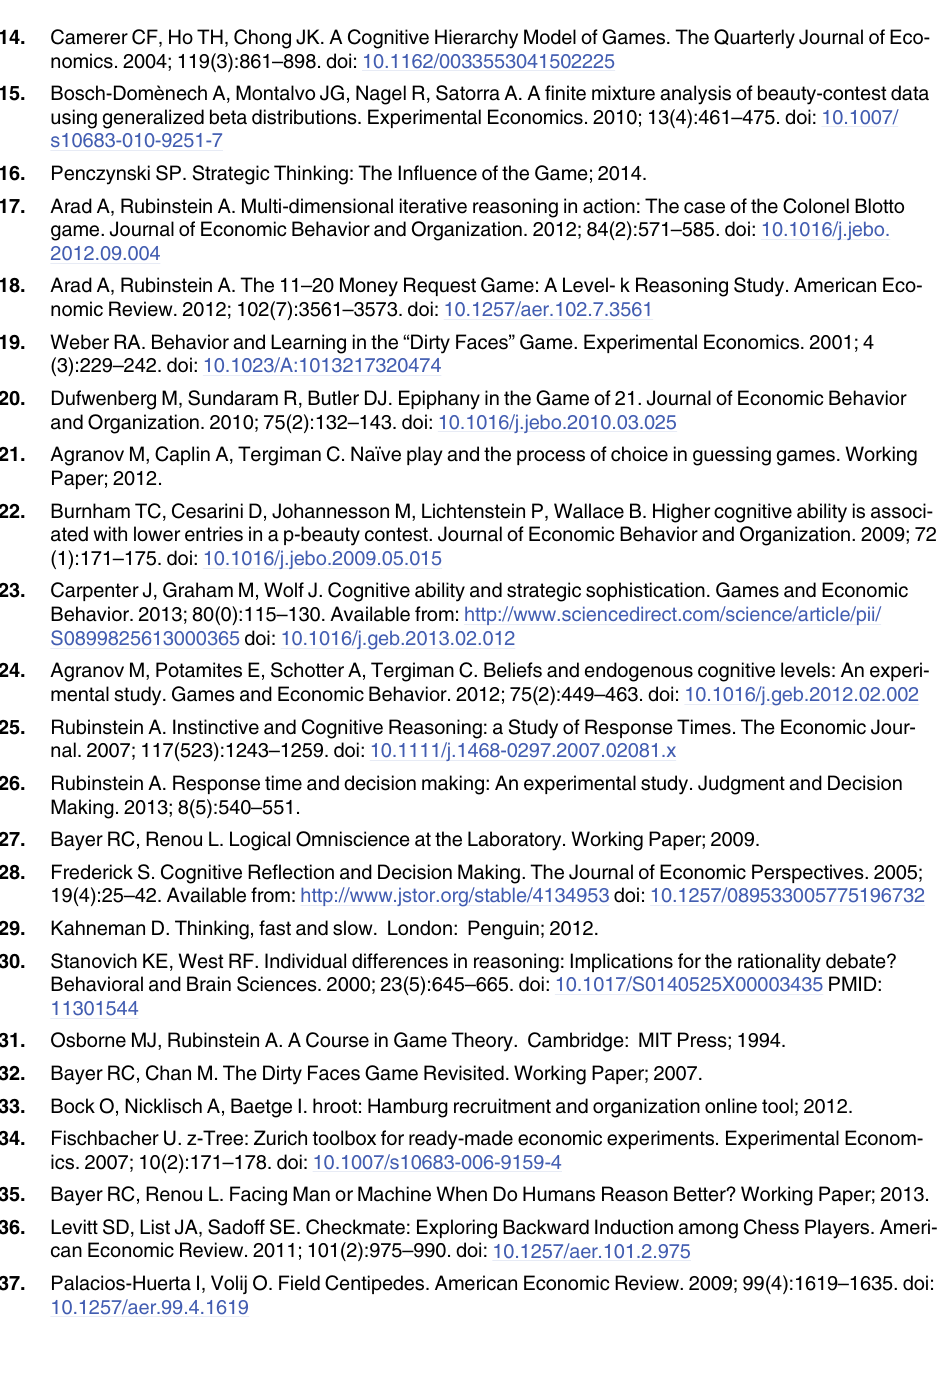
PLOS ONE | DOI:10.1371/journal.pone.0136524 August 27,